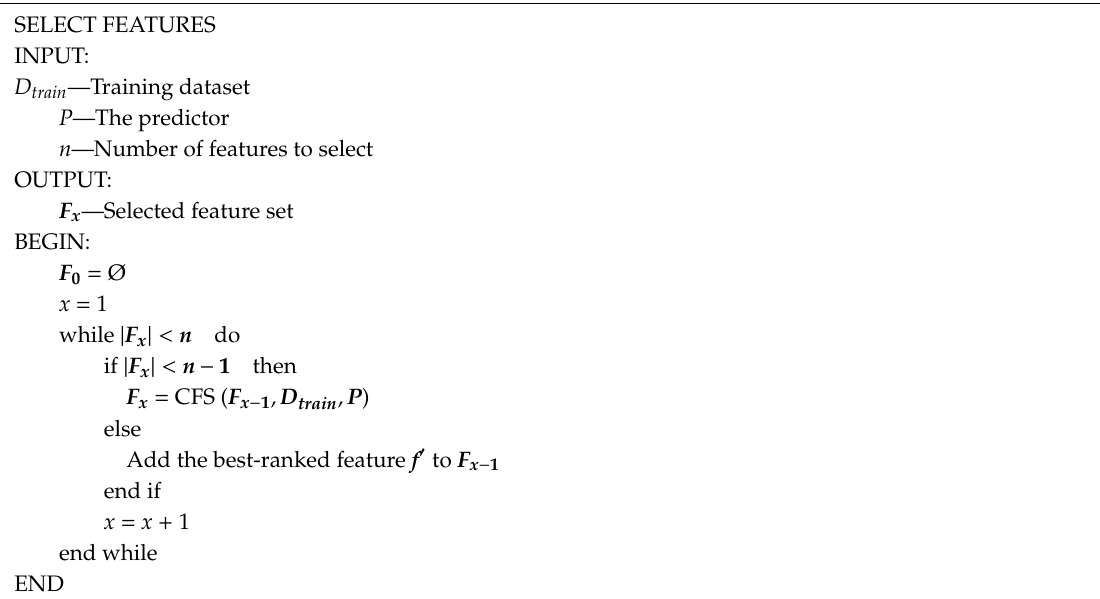
Algorithm 1 CFS filter-based feature selection